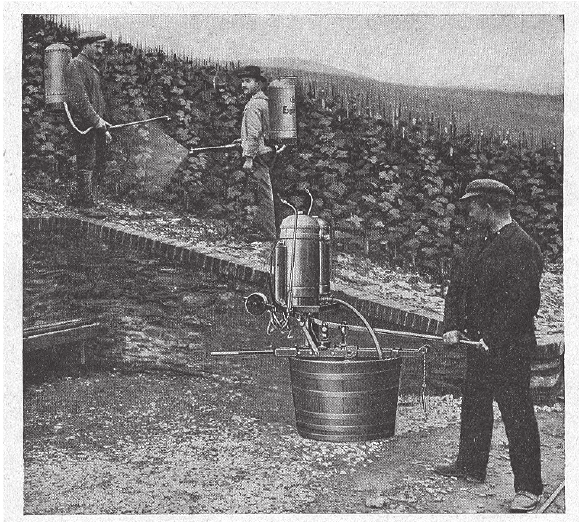
Figure 12. Application of Bordeaux mixture using pressure filling device and sprayer type Express, Ludwigshafen Germany (foto from Müller,